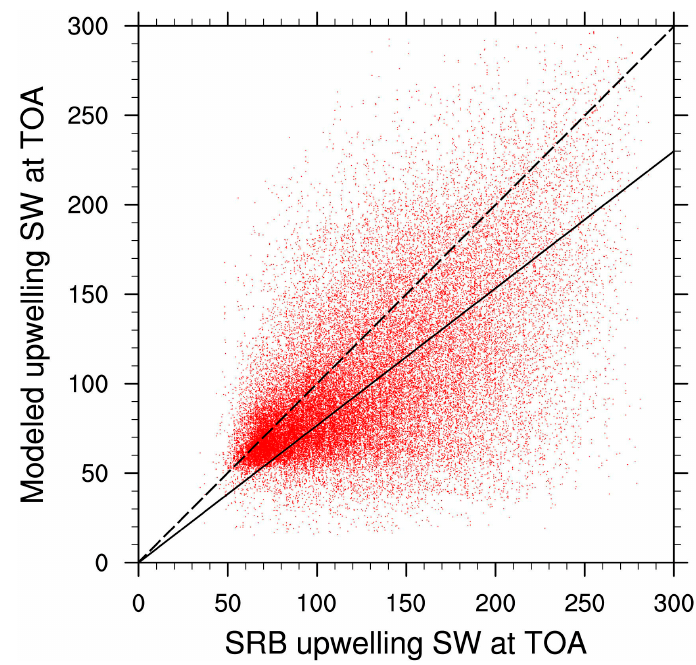
Figure 1. Scatter plot of modeled daily SW TOA ↑ (shortwave TOA) versus Surface Radiation Budget (SRB) daily SW TOA ↑ (unit: W/m 2 ). Dashed line and solid line represent 1:1 line and regression line, respectively.